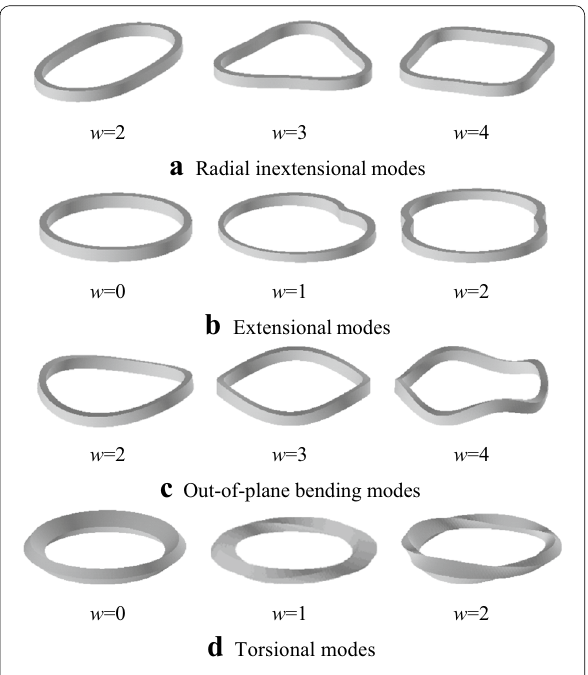
Figure 3 Typical helical ring gear’s vibration